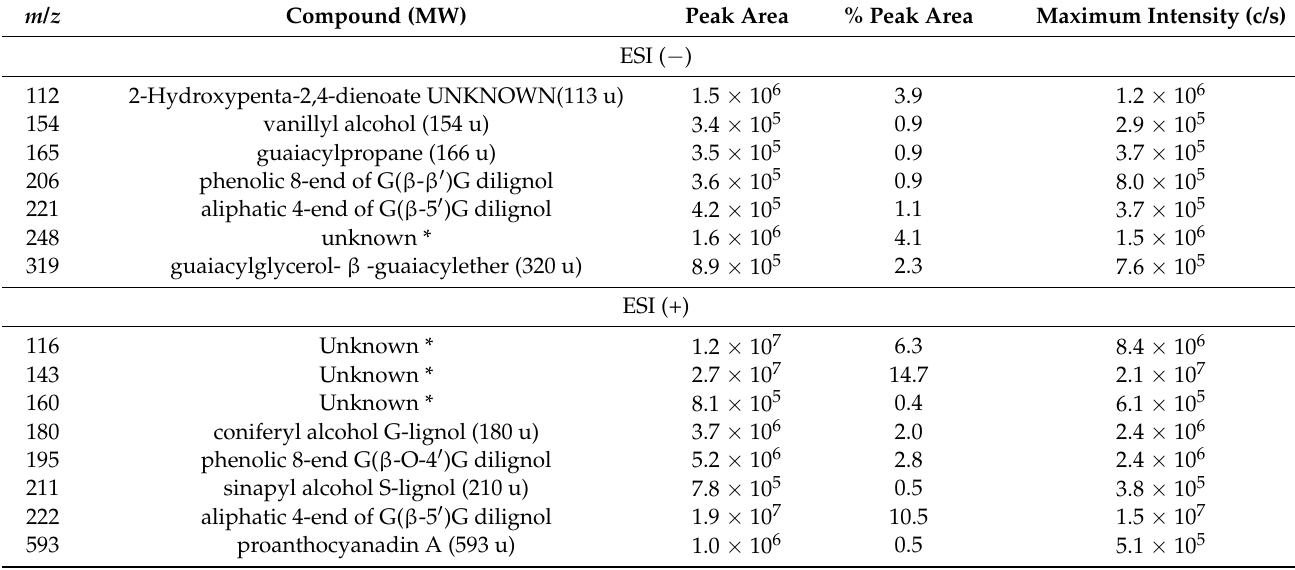
Table 3. Identified bioactive components characterized by FIA-ESI-MS of acidified methanol (1% HCl) soluble components of pecan shell Nacono ethanol